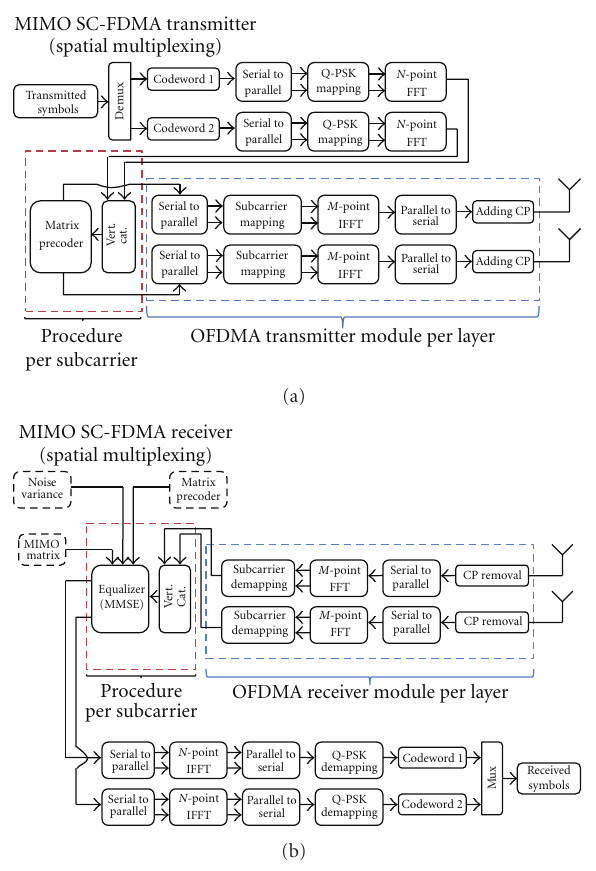
Figure 1: Transmitter and receiver structure of a 2 × 2 MIMO SC- FDMA